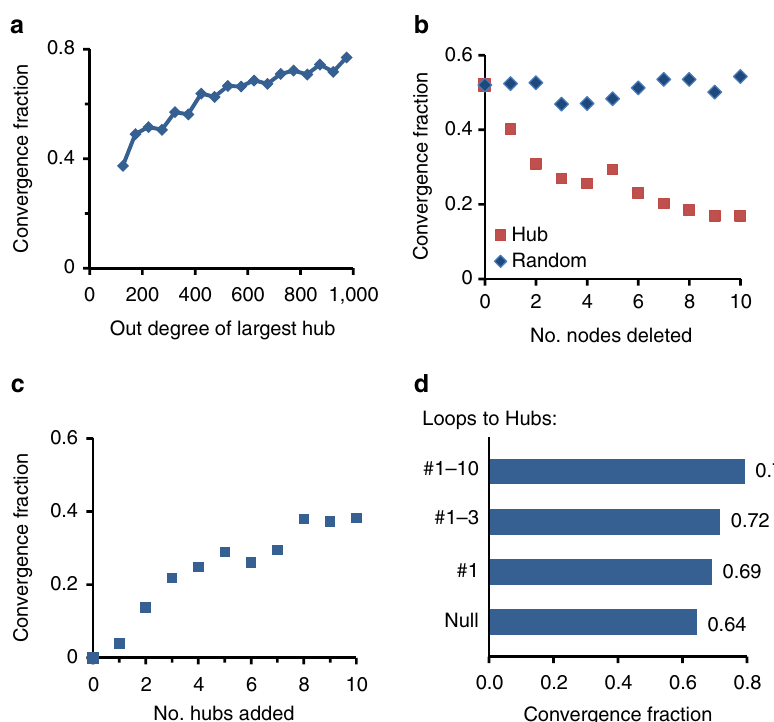
Figure 3 | Exploratory adaptation depends on the existence of hubs and is enhanced by their auto-regulation. ( a ) CF versus out-degree of the largest hub in a collection of SF-Binom networks binned according to their largest hub. ( b ) Changes in Convergence Fraction (CF) following deletion of a number of leading hubs (red) or deletion of the same number of random nodes (blue) from networks with SF-Binom topology. ( c ) Effect of adding a small number of outgoing hubs to a Binon-Binom ensemble. The out-degrees of the added hubs were chosen to mimic the SF-out ensemble of Fig. 2. ( d ) Effect of adding autoregulatory loops on a specific number (1, 3 and 10) of the leading outgoing hubs on a background of a SF-Binom ensemble. N ¼ 1,500, y (cid:5) ¼ 0, g 0 ¼ 10, D ¼ 10 (cid:2) 3 . Parameters for degree distributions: SF, ( a ¼ 1, g ¼ 2.4); Binom, p ’ 3 : 5 ; N (cid:2) (cid:3) ; Exp, ( b ¼ N